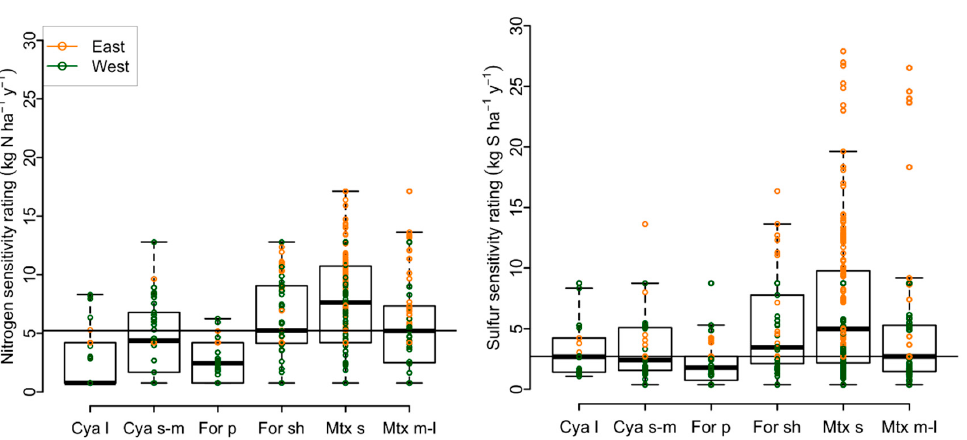
Figure 4. Box and whisker plots of lichen sensitivity ratings by functional group. Boxes enclose 25–75% quantiles, whiskers mark upper and lower outliers (1.5 times the interquartile range). The horizontal line indicates the overall median for the pollutant. Very few cyanolichens or pendant forage lichens were tolerant to S or N (sensitivity rating > 8 kg ha − 1 y − 1 ). Medium to large matrix lichens